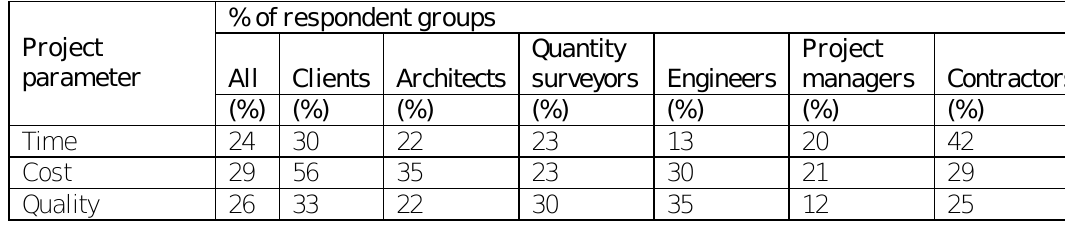
Table 4: Perceived extent to which inadequate briefing of the procurement team by the client is always responsible for client dissatisfaction with the resultant building in terms of time, cost and